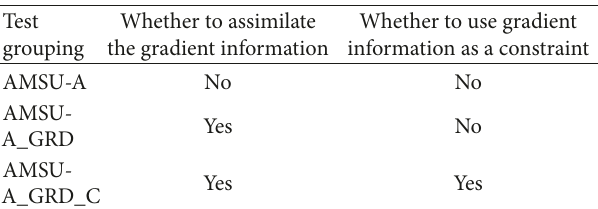
Table 1: Schemes of ideal